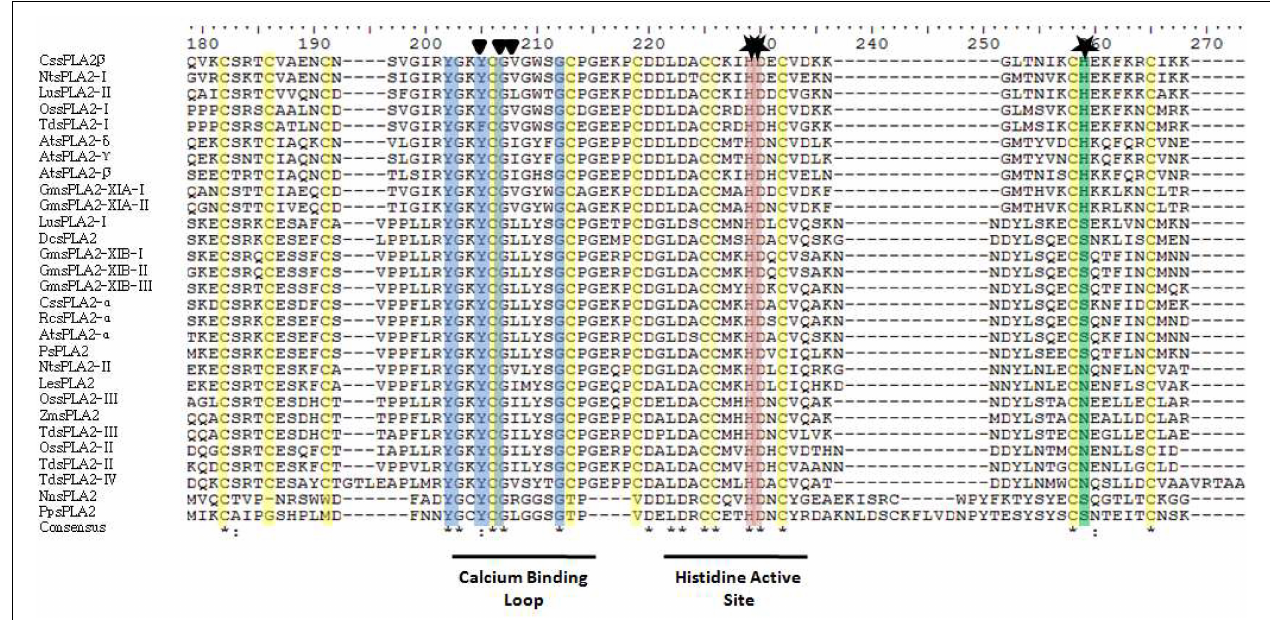
FIGURE 3 | Sequence alignment of the sPLA 2 s reported from plants: analysis of the deduced amino acid sequences. The alignment was performed by using the Clustal X v2.1 program (http://www.clustal.org) and edited with jalview program. The triangles denote the amino acid residues involved in binding Ca 2 + and stars denote amino acid residues putatively involved in catalysis. In yellow, CYS residues are marked. For abbreviation code of plants sPLA 2 see Table 2 . Two animals sPLA 2 are included at the bottom of the figure for comparison: Nn sPLA 2 from Naja naja (cobra) venom and Pp sPLA 2 from pig pancreatic juice ( Sus scrofa ). The accession numbers of sPLA 2 indicated in this figure are provided as Supplementary Appendix S1